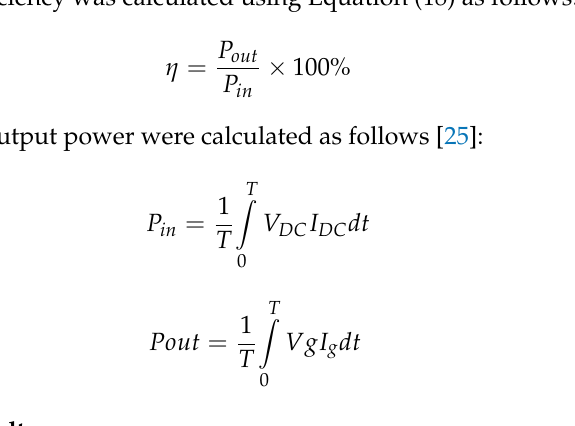
Figure 14. Bode diagram of the inverter controller: ( a ) Magnitude plot, ( b ) Phase plot.